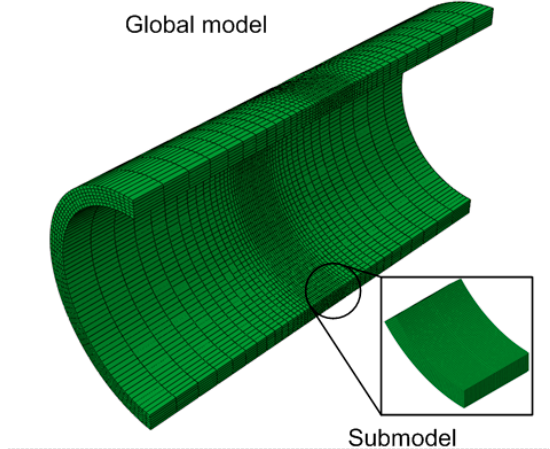
Figure 6. Finite element mesh of welded